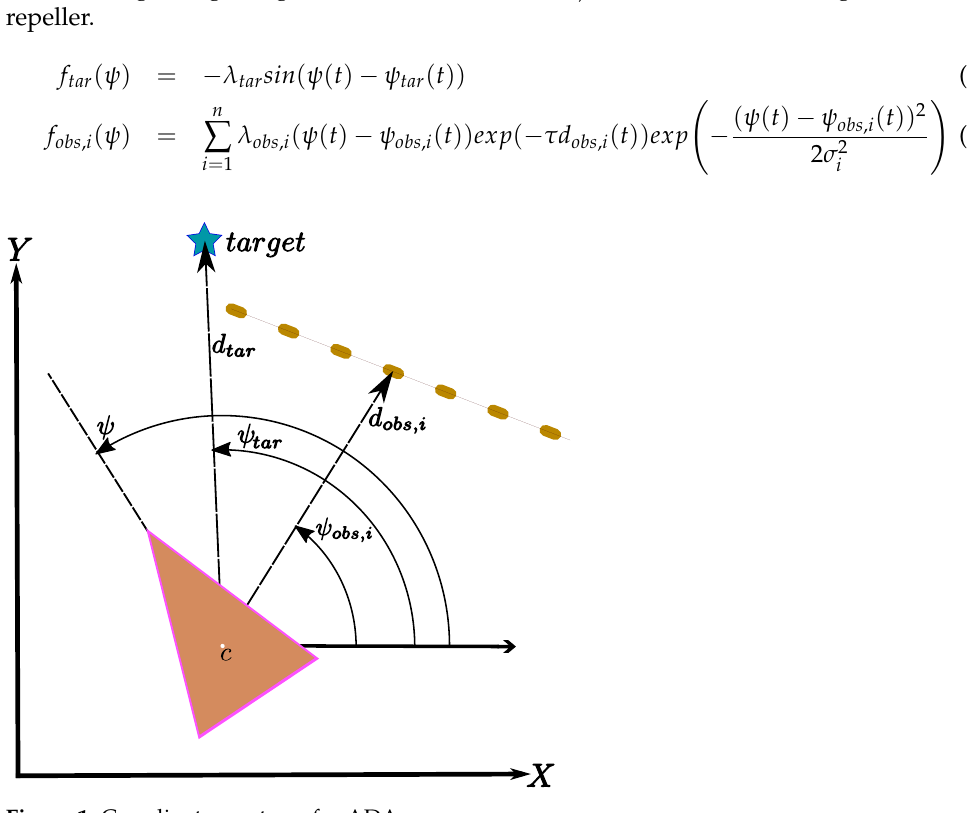
Figure 1. Coordinates systems for